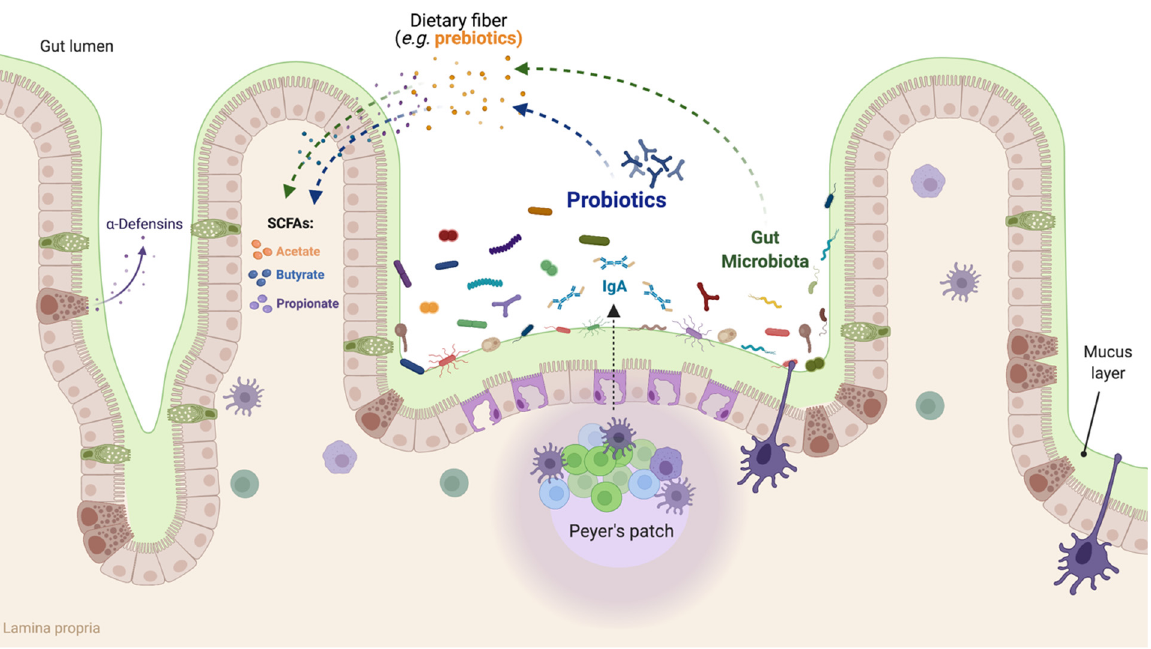
Figure 2. Some of the proposed mechanisms by which probiotics exert their beneficial effects. This figure was created with biorender.com (accessed date: 26 April 2022). figure was created with biorender.com (accessed date: 26 April